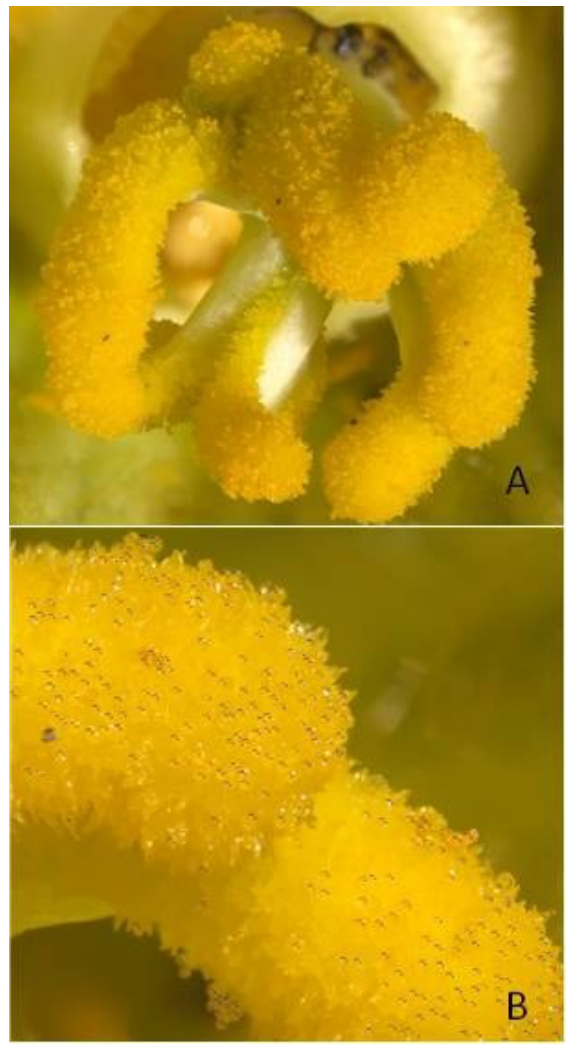
F IGURE 7. Counting pollen on larger stigmas with stigmagraphs. A) A focus-stacked stigmagraph of the multi-lobed stigma of a pumpkin flower (Cucurbita pepo L.). B) A section of the stigmatic surface with the individual pollen grains counted using Fiji’s Cell